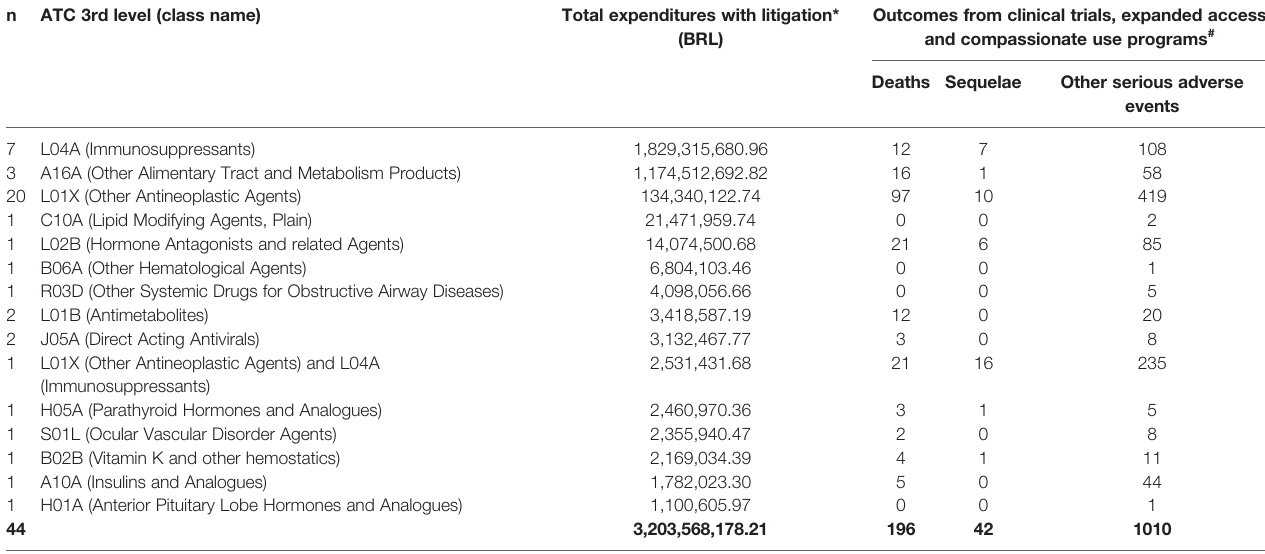
TABLE 1 | Number of experimental drugs demanded through litigation, ATC 3 rd level classi fi cation, incurred expenditures (BRL) and related